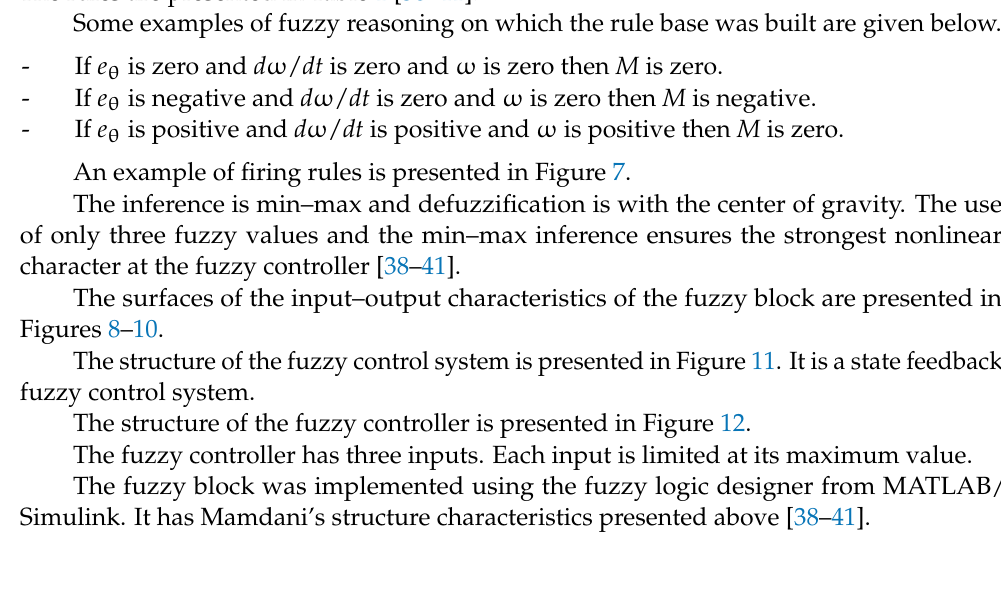
Table 1. Rule base.